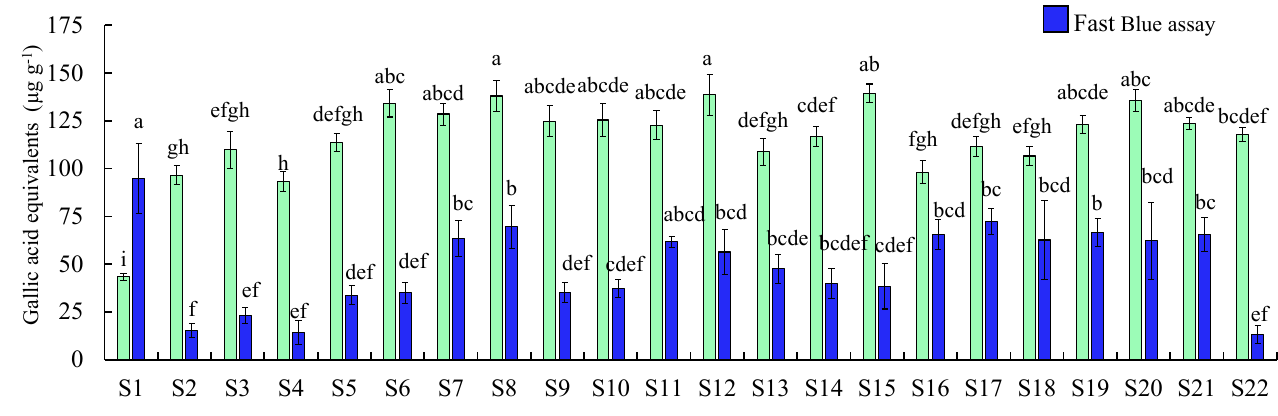
Figure 3. Total phenolic content measure by the Folin–Ciocalteu and Fast Blue assay in cantaloupe extracts. Solvent com-